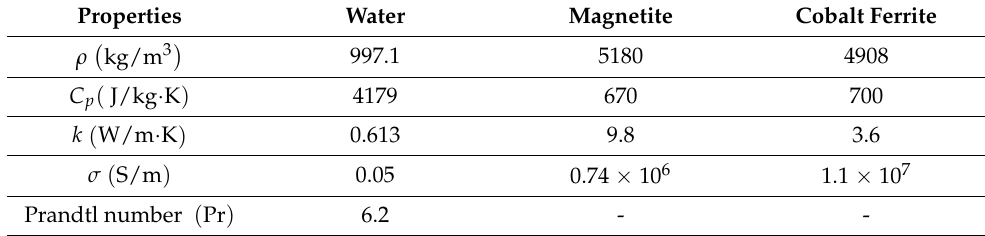
Table 1. Physical